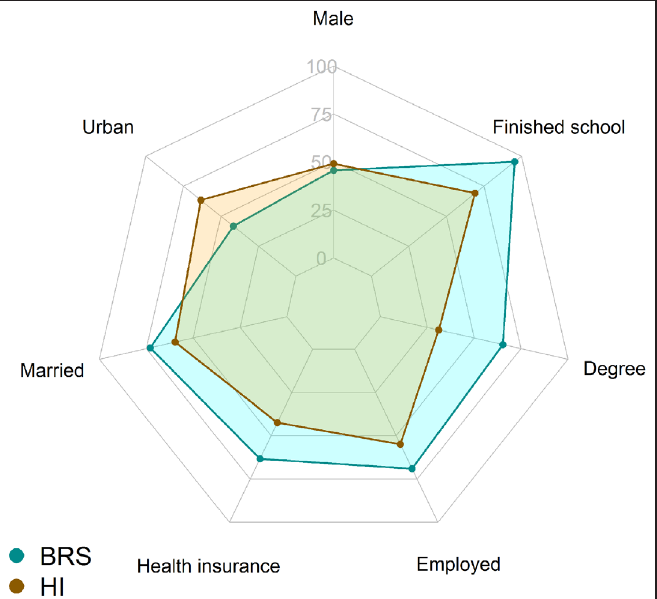
Figure 9: Demographic characteristics of biodiversity recorders compared with those of adult population in Ireland using Healthy Ireland Survey